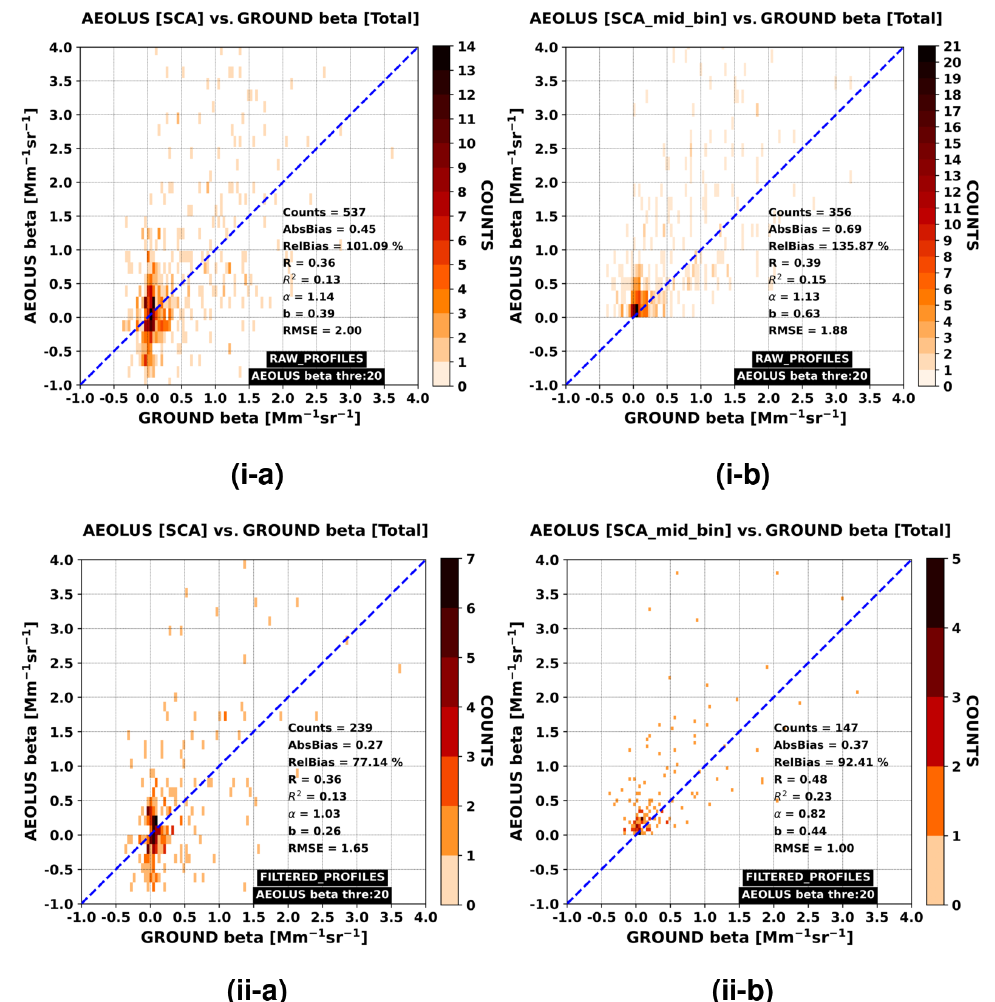
Figure 6. The 2D histograms between Aeolus ( y axis) and ground-based ( x axis) backscatter coefficient retrievals. In the upper (i) and lower (ii) panels, the results for the cloud plus aerosol backscatter (unfiltered) and cloud-cleared backscatter (filtered) Aeolus profiles are depicted, respectively. In the left and right columns, the results corresponding to Aeolus regular (24 bins) and mid-bin (23 bins) vertical scales are illustrated, respectively. Aeolus backscatter values larger than 20Mm − 1 sr − 1 are masked out from the collocated sample.